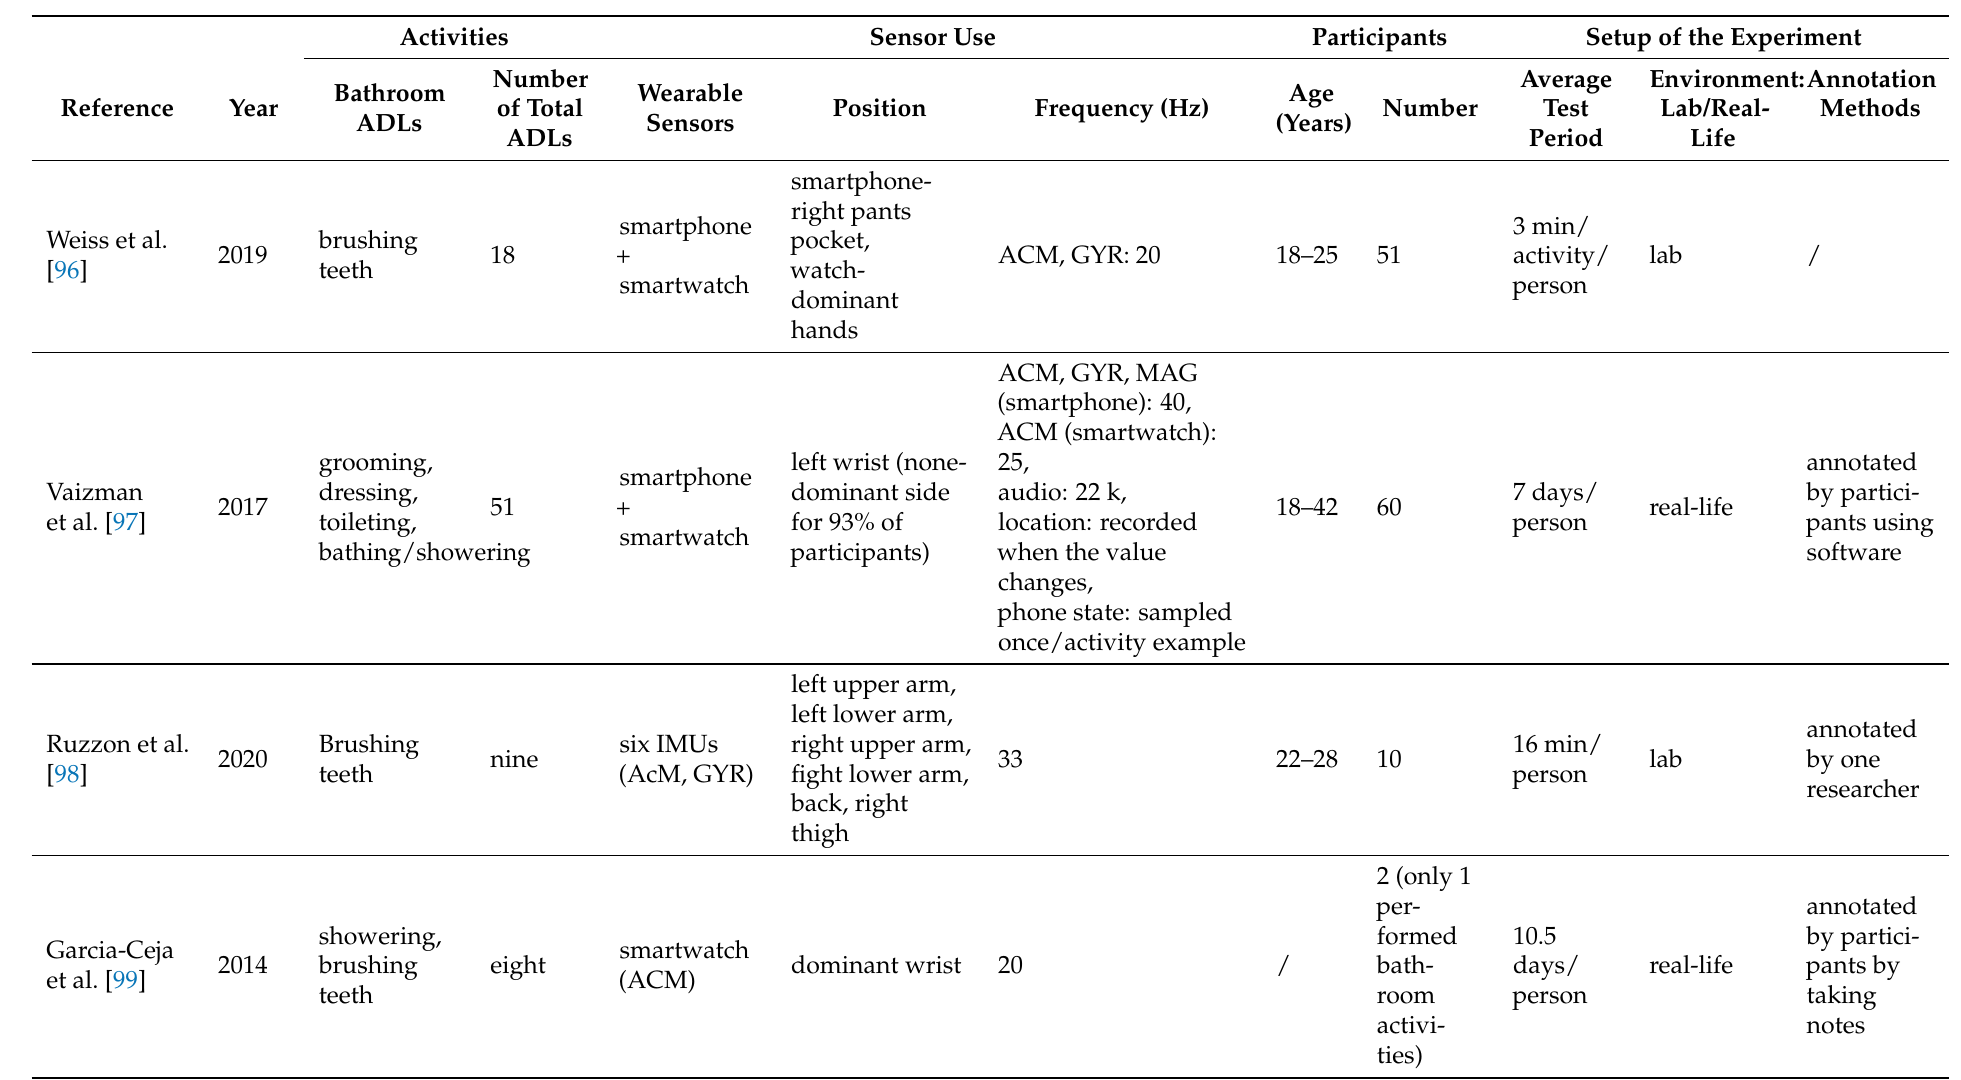
Table 5. Overview of the public data set regarding activities, sensor use, participants and setup of the